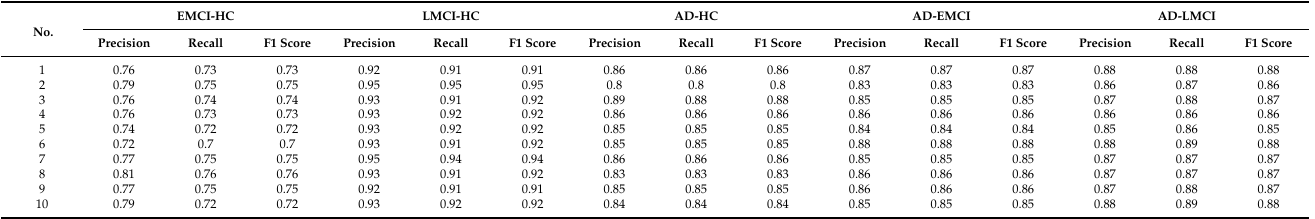
Figure 10. The boxplot of our models in five datasets. Table 3. The Precision, Recall and F1 score of our model in 10 independent experiments.